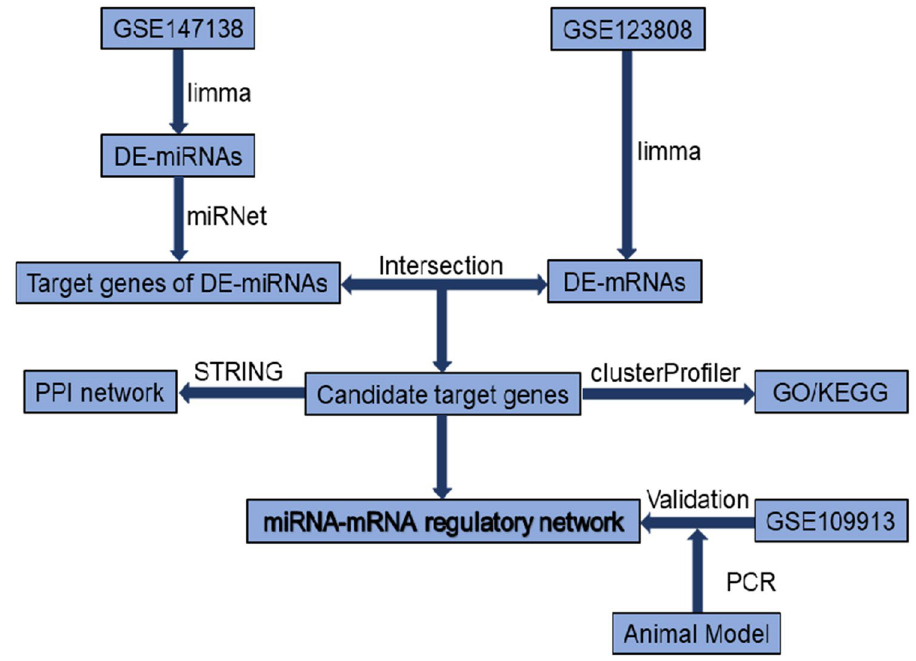
Figure 1. The flowchart of our